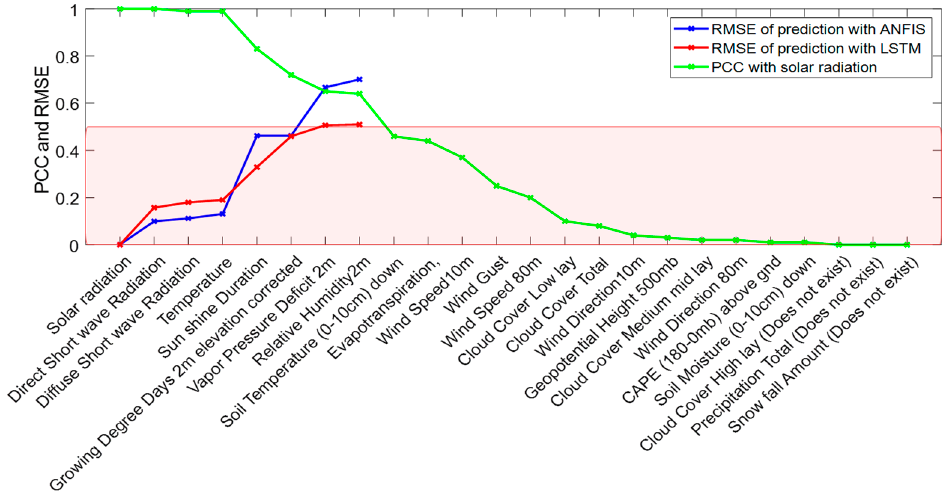
Figure 8. Meteorological parameters’ ranking based on Pearson Correlation Coefficients and Comparative performance of LSTM and ANFIS models with significant parameters selection (PCC value ≥ 0.5) (employed dataset from 1 January 2017, until 22 August 2021).